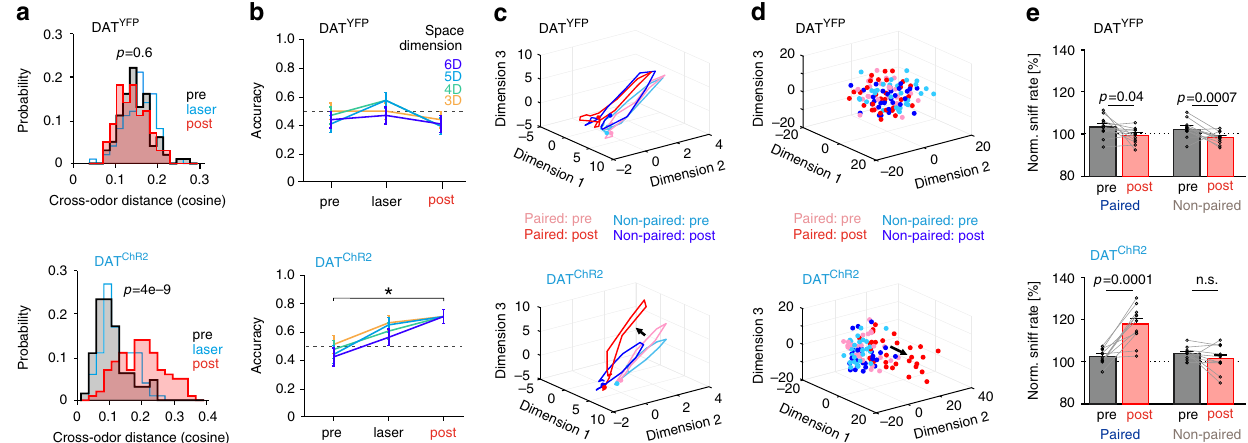
Fig. 2 Phasic DA increases the difference between the paired and non-paired odor encoding and improves decoding. a Distribution of the cosine distance between the two odor responses during ‘ pre ’ and ‘ post ’ phases. After pDA pairing, cross-odor distance increased only in DAT ChR2 mice (two-way ANOVA; factors: cohort, odor; interaction effect: F(1,360) = 90.6, p = 3 × 10 − 19 ; post hoc comparisons indicated, Tukey ’ s correction). b Quadratic discriminant analysis between paired and non-paired odor responses. Only in DAT ChR2 mice, laser pairing improved the average accuracy (two-sided Fisher ’ s exact test between ‘ pre ’ vs ‘ post ’ ; multiple state space dimensions are tested to con fi rm the robustness, α = 0.05 with Benjamini – Hochberg correction on tests performed on all dimensions and cohorts, DAT ChR2 : asterisk mark signi fi cance for all dimensions, DAT YFP : no signi fi cance in any dimension. DAT YFP : n = 60 accuracy values for all dimensions and phases; DAT ChR2 : n = 52/62/62 accuracy values for all dimensions and for ‘ pre ’ / ’ laser ’ / ’ post ’ phases, resp.; displayed mean ± S.E.). c Averaged trajectories for paired and non-paired SPN odor responses visualized through factor analysis